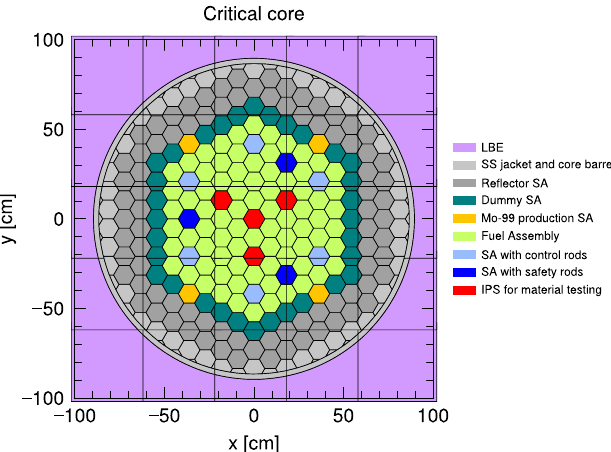
Fig. 1. Horizontal sectional view of MYRRHA